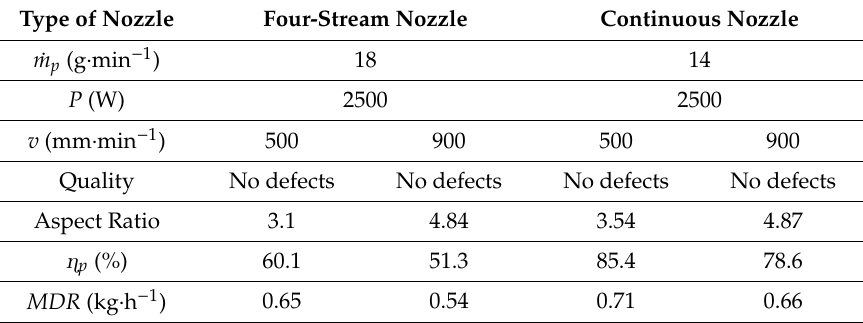
Table 5. Selected clad parameters and characteristics.